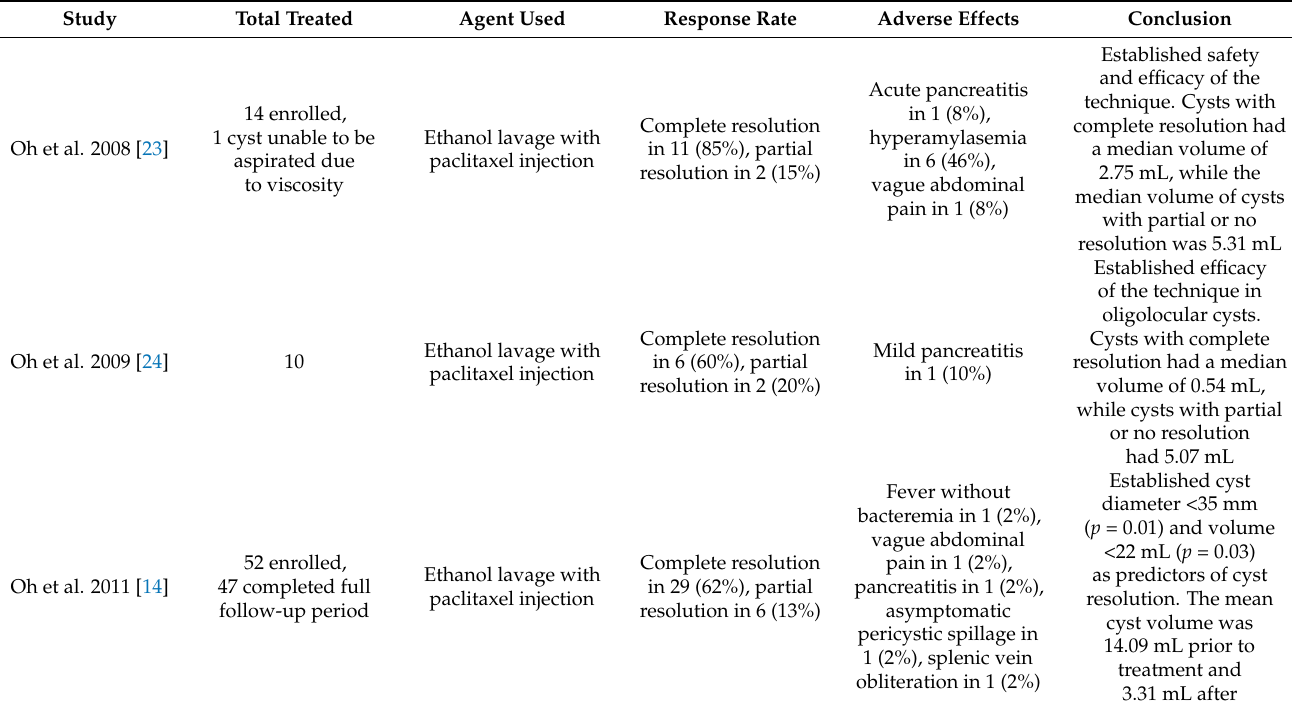
Table 1. EUS-guided chemoablation of pancreatic cystic lesions: Published studies with enrollment data, agent used, response rate, adverse events, and study